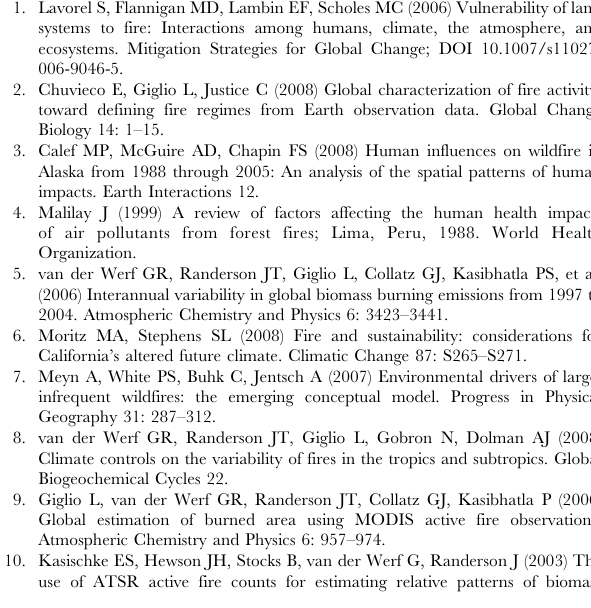
sub-models. Values on x-axis are presented as approximate g C/ m 2 /year, by dividing data (g C/0.25 decimal degree cell) by 7.7 6 10 8 . The values for NPP are clipped to the extent of the GFDL CM2.1 climate data used in the regression models, such that areas of white along some coast-lines indicate areas not included in the study. Found at: doi:10.1371/journal.pone.0005102.s004 (1.09 MB TIF) Figure S5 Changes in the global distribution of fire-prone pixels under the B1 (low) emissions scenario. An increase from current conditions (red) is indicated by P D greater than unity, little or no change (yellow) is indicated by P D around unity, and a decrease (green) is indicated by P D less than unity. Panels show the mean P D for the ensemble of ten FIRE NPP (A–C) and FIRE noNPP (D–F) sub- models. Climate projections include 2010–2039 (A, D), 2040– 2069 (B, E) and 2070–2099 (C, F). Found at: doi:10.1371/journal.pone.0005102.s005 (1.38 MB TIF) Figure S6 Distribution in values of change in the relative probability of fire (P D ) under future conditions. Figure S7 A comparison of mean temperature of the warmest month from 15 AOGCMs. Periods of comparison include: 2010– 2039 (A), 2040–2069 (B) and 2070–2099 (C), under the SRES A2 (mid-high) emissions scenario. The GFDL CM2.1 projections (outlined) fall in the mid-range of all models - half of the models show warmer temperatures and half show cooler. Figure S8 Comparison of annual precipitation from 15 AOGCMs. Periods of comparison include: 2010–2039 (A), 2040–2069 (B) and 2070–2099 (C), under the SRES A2 (mid- high) emissions scenario. The GFDL CM2.1 projections (outlined) are in the lower half of the 15 models. Although there are several models that project significantly drier conditions than GFDL CM2.1, in general by end-of-century its projections show smaller precipitation increases (across northern Europe, along the west coasts of the Americas, and in mid-Africa) than the majority of models.